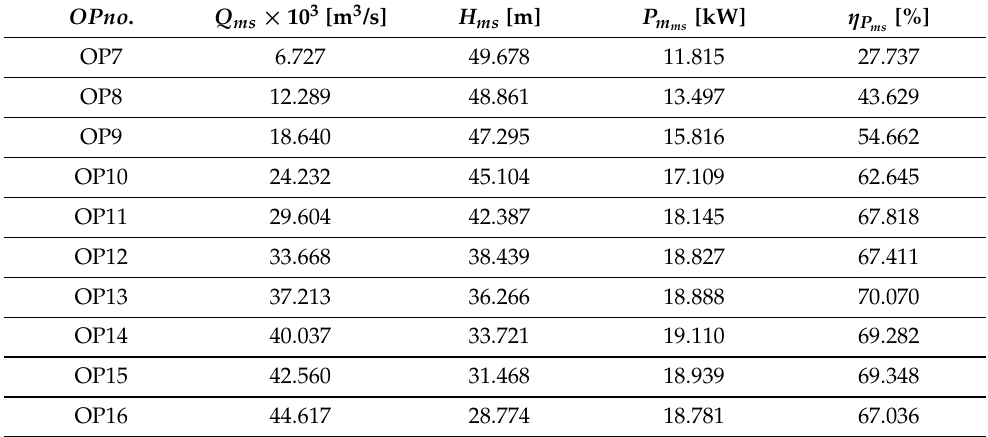
Table 1. The experimental data determined for centrifugal pump PCN 65/200 at speed of 2900 rpm. OPno .